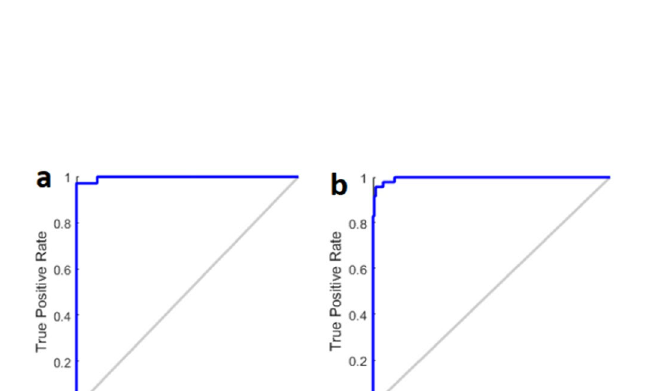
Figure 3. ( a ) Clark error grid plot illustrating all points are in region A (clinically accurate, +/− 20% error), ( b ) Bland–Altman (95% confidence plot). ( c ) Histogram illustrating age of training cohorts (N = 401) having median at 50 years. ( d ) Histogram of the testing group (N = 234).